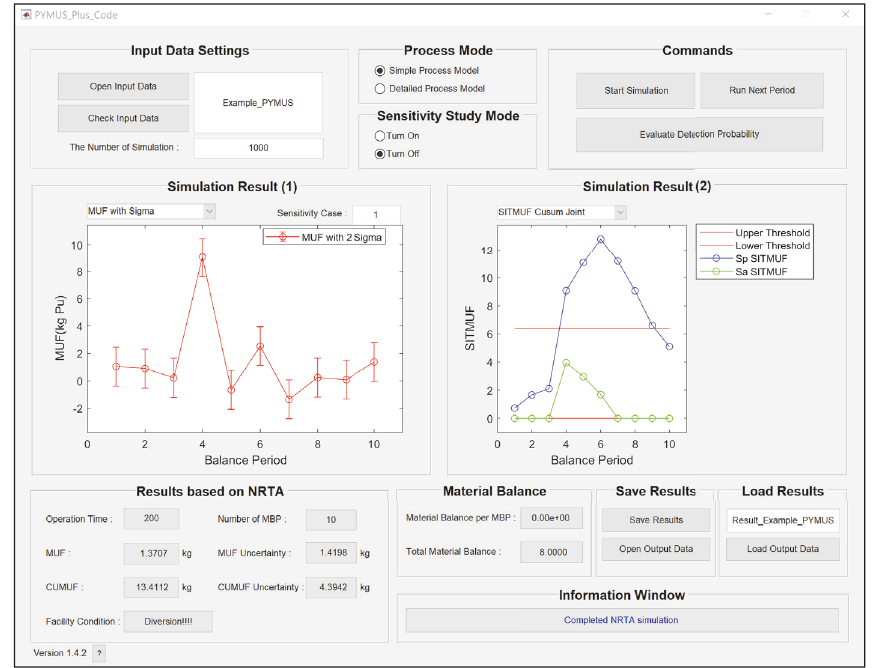
Figure 4: Main screen of PYMUS+